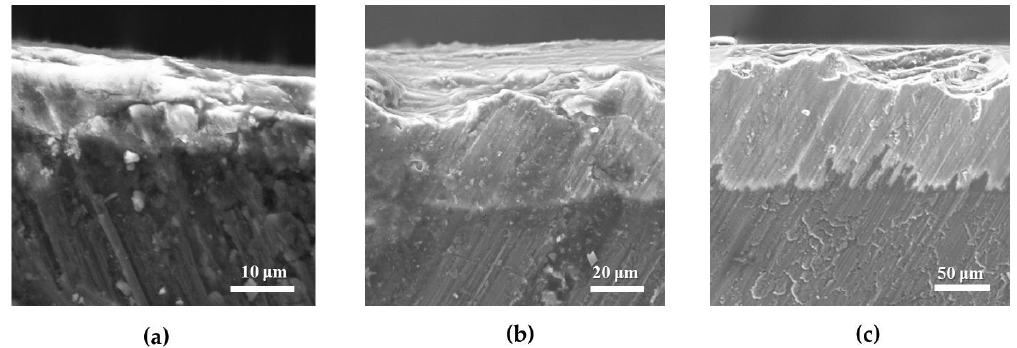
Figure 3. FEGSEM cross sections of the samples (from left to right: ( a ) GHA10, ( b ) GHA50 and ( c ) GHA100).